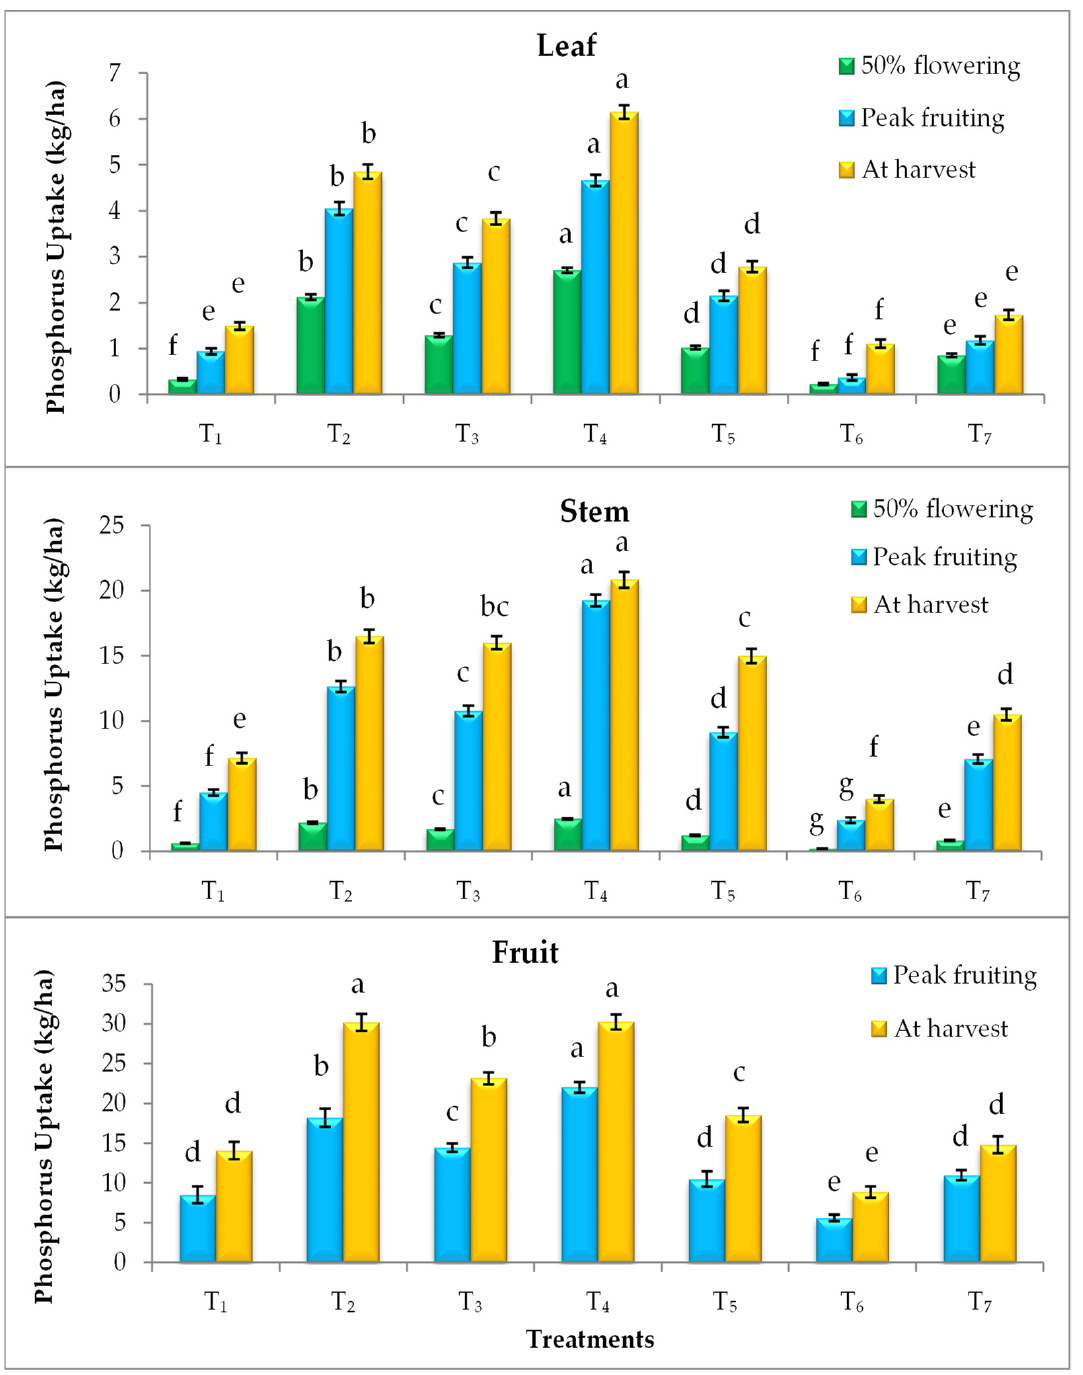
Figure 2 . Phosphorus uptake by leaf, stem and fruit of tomato plants as influenced by elevated CO 2 and temperature at 50% flowering, peak fruiting and at harvest stages ( n = 15). Note: According to DMRT, values with same alphabet(s) do not differ statistically at the 0.05 level; Refer Table 1 for the description of the treatments.